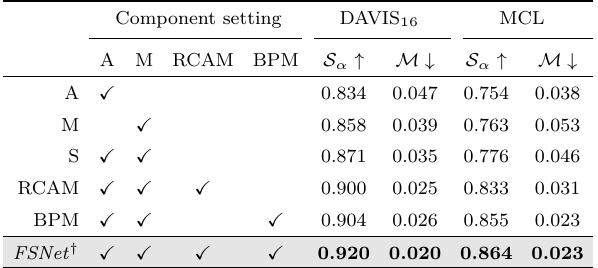
Table 4 Ablation studies for our components on DAVIS 16 and MCL. N = 4 for BPM. A=Appearance. M=Motion. S=Simple. RCAM= RCAM only. BPM = BPM only Component setting DAVIS 16 MCL